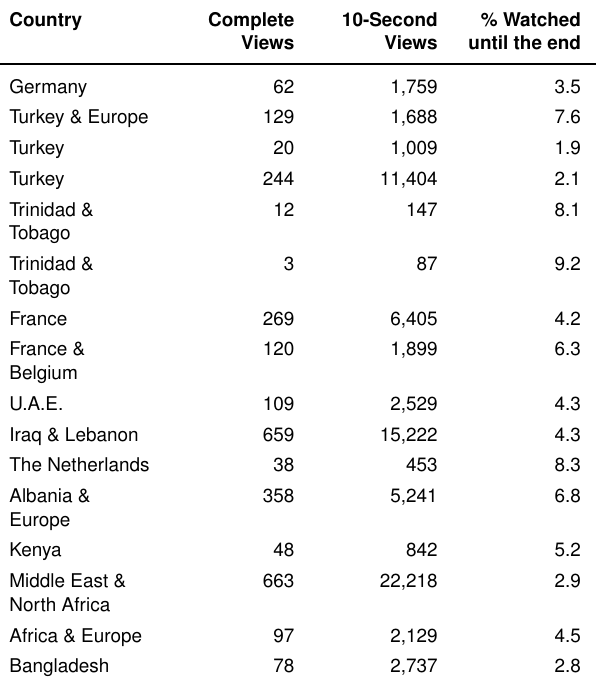
Table 6. Video engagement